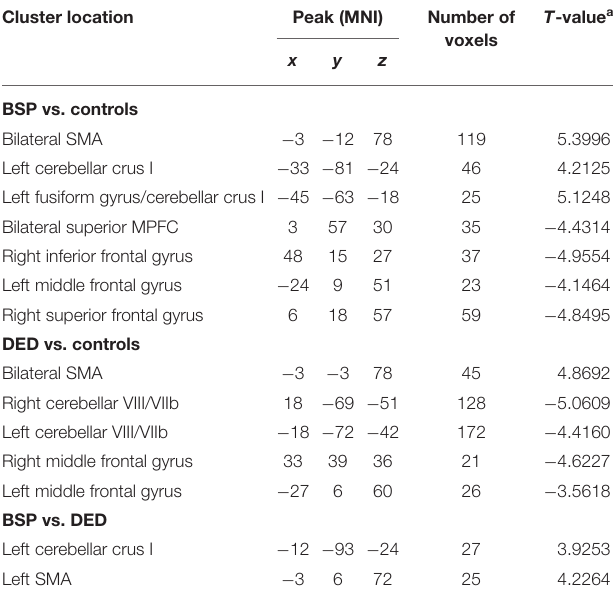
TABLE 2 | Regions with abnormal ALFF in the patients. Cluster